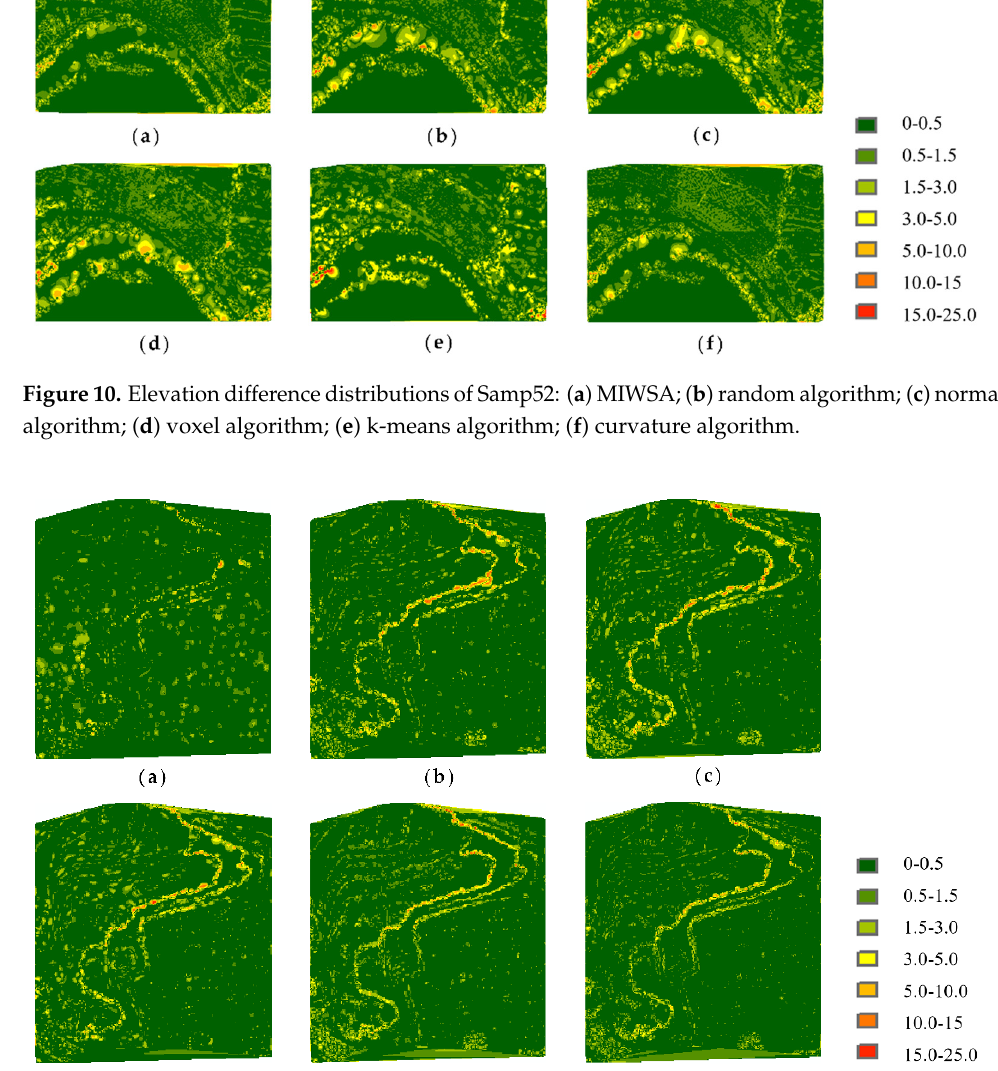
Figure 11. Elevation difference distributions of Samp53: ( a ) MIWSA; ( b ) random algorithm; ( c ) normal algorithm; ( d ) voxel algorithm; ( e ) k-means algorithm; ( f ) curvature algorithm.